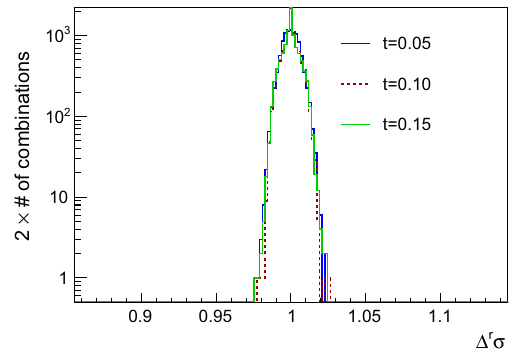
0.5 σ r Δ Fig. 13 Ratio of the uncertainties on the combined value obtained neglecting correlations between uncertainties within a measurement and using a direct likelihood combination. The distribution is shown for different values of the upper threshold for systematic uncertainties t . For comparison with the method proposed here, see Figs. 3 and